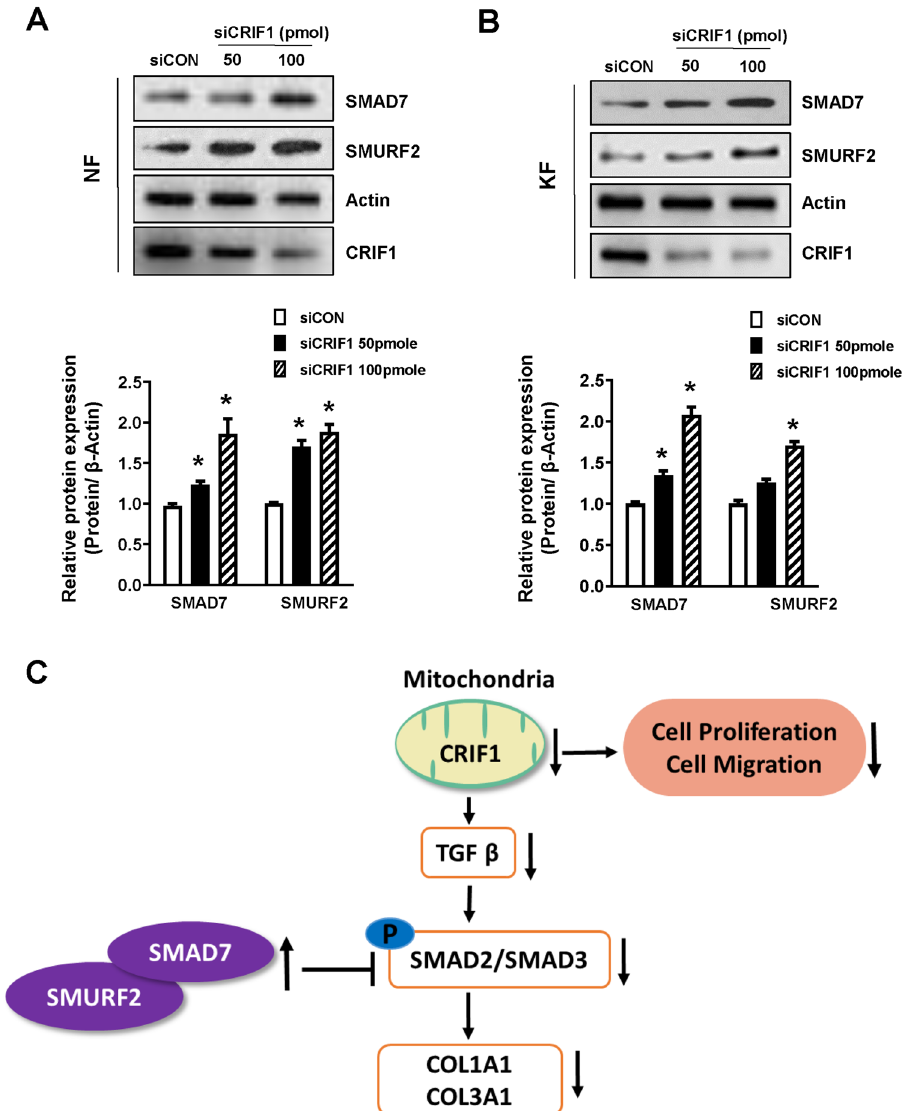
Figure 8. Smad7 and SMURF2 protein levels are altered by CRIF1 downregulation in normal fibroblasts (NFs) and keloid fibroblasts (KFs). ( A ) NFs were transfected with CRIF1 siRNA in a dose-dependent manner for 48 h. After 48 h incubation, cells were harvested, lysed, and analyzed by western blot to assess differences in protein levels of SMAD7 and SMURF2; β-actin was used as the loading control. Protein density was calculated using ImageJ software. Full-length blots are presented in Supplementary Fig. S6a. ( B ) KFs were transfected with CRIF1 siRNA in a dose-dependent manner for 48 h. After 48 h incubation, cells were harvested, lysed, and analyzed by western blot to assess differences in protein levels of SMAD7 and SMURF2; β-actin was used as the loading control. Protein density was calculated using ImageJ software. Full-length blots are presented in Supplementary Fig. S6b. All data are presented as the mean ± SD of three independent experiments. * P < 0.05 compared to siCON. ( C ) Schematic representation of CRIF1 downregulation induced changes in the TGF-β/ Smad signaling pathway leading to the inhibition of invasive